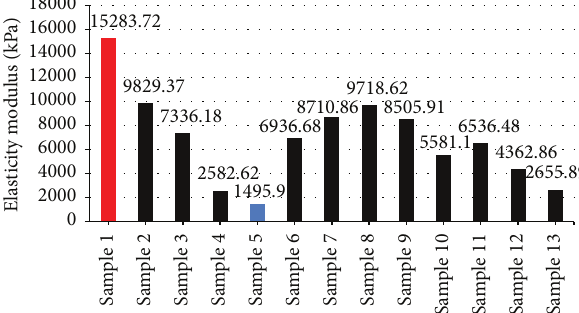
Figure 4: Distribution of elasticity modulus in